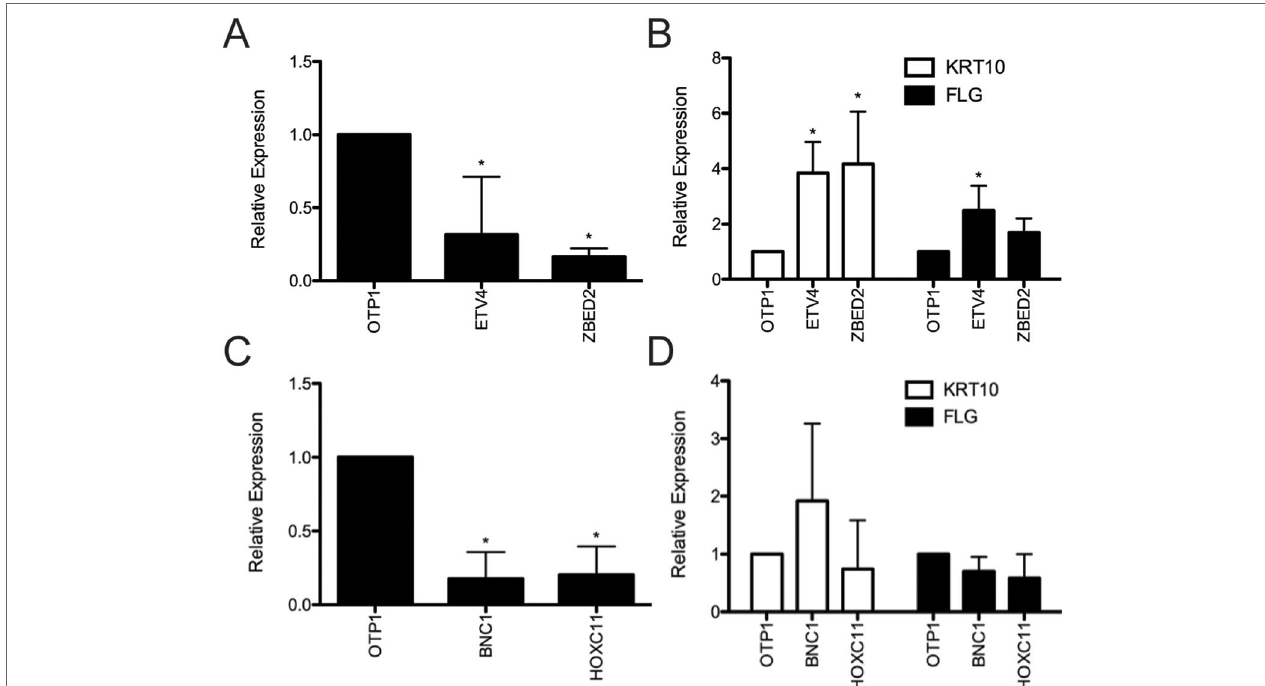
FIGURE 2 | Evaluation of predicted keratinocyte regulators via siRNA knockdown. (A) RNA was harvested 4 days after transfection from primary human keratinocyte culture treated with ETV4 , ZBED2 , or negative control siRNA. Quantitative polymerase chain reaction analysis showed significant ( p < 0.05, Student t test) knockdown of ETV4 and ZBED2 mRNA relative to nontargeting siRNA transfected cells. (B) Expression of KRT10 and FLG transcript following siRNA knockdown of ETV4 or ZBED2 , relative to control. Asterisks indicate p < 0.05 (Student t test). (C) same as (A) but for BNC1 and HOXC11. (D) Knockdown of BNC1 and HOXC11 did not significantly change expression of differentiation marker genes KRT10 and FLG . Error bars indicate 1 standard deviation calculated over four